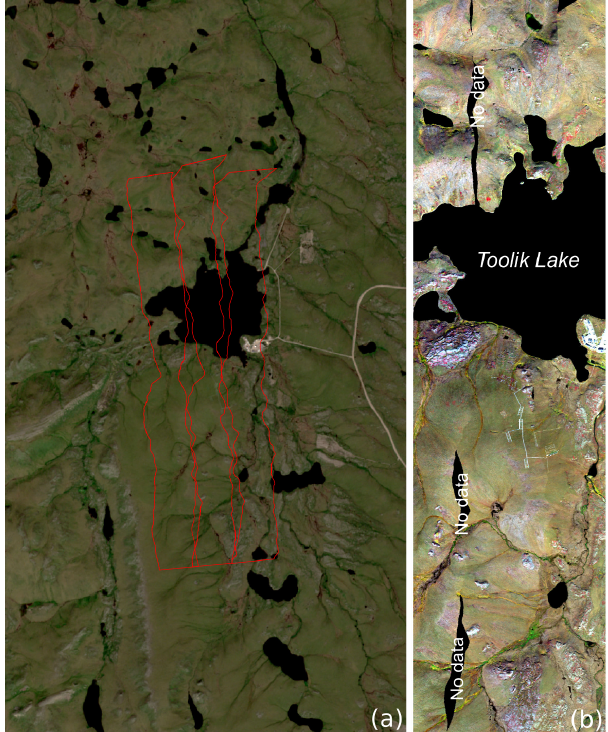
Figure 18. Toolik Lake, Alaska. (a) Sentinel-2 image (21 July 2016) with airborne hyperspectral flight lines in red; (b) AISA Eagle hy- perspectral image (1.3m) (Beamish et al.,